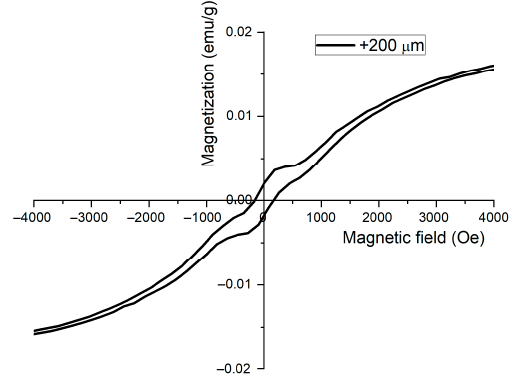
Figure 10. Hysteresis loop for the 200–400 µ m particle size exhibiting two magnetic components. From the hysteresis loop, a bi-phasic magnetic behavior is noticed. This change indicates the presence of two magnetic components in the sand. The identification of the two magnetic components was obtained by performing a magnetic separation of the sand with two magnets presenting different energies. The magnet with low energy will attract the particles with a strong ferromagnetic behavior, while the magnet with high energy will attract the particles with weak ferromagnetic behavior. After separating the high and low magnetic component, X-ray diffraction was performed for phase identification, as depicted in Figure